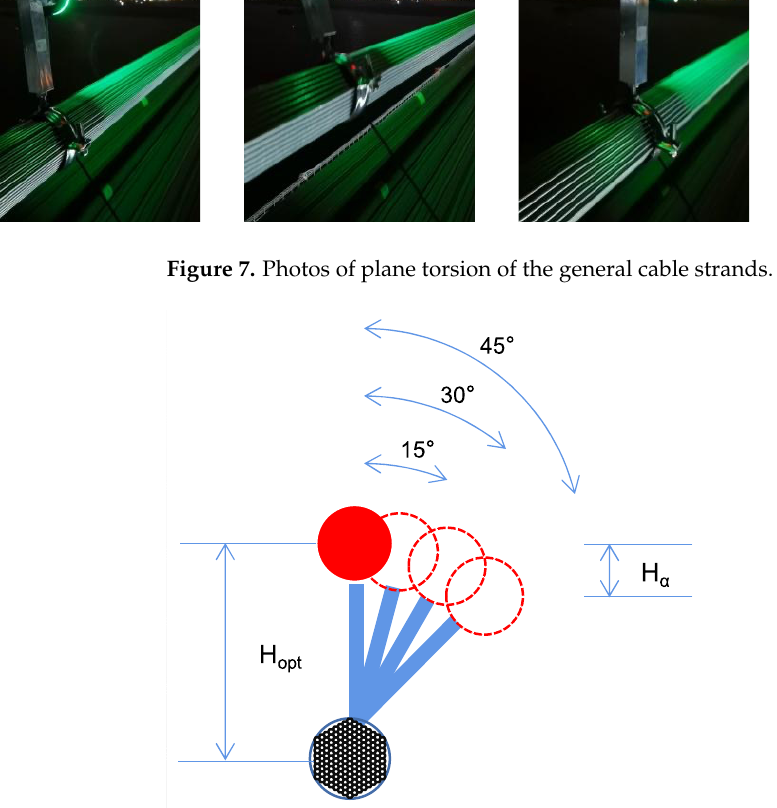
Figure 8. Schematic diagram of plane torsion of a cable strand.